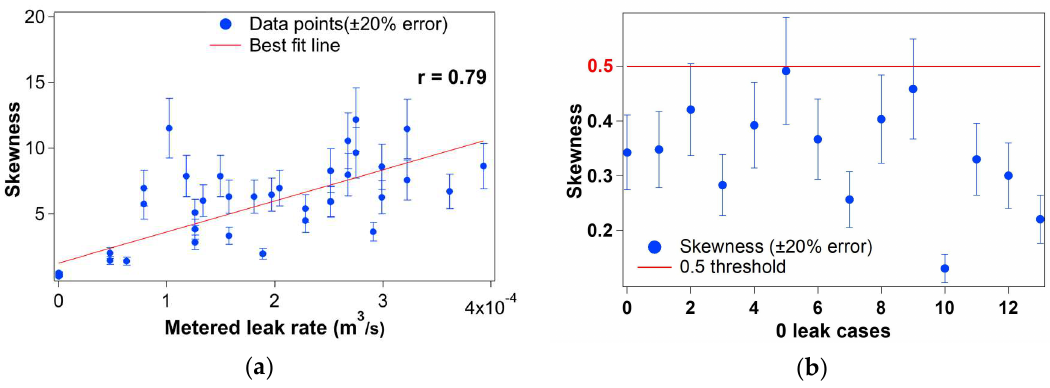
Figure 14. ( a ) Skewness versus metered leak rate for all cases. ( b ) Skewness for zero-leak cases only. The 20% error was calculated based on each skewness value.